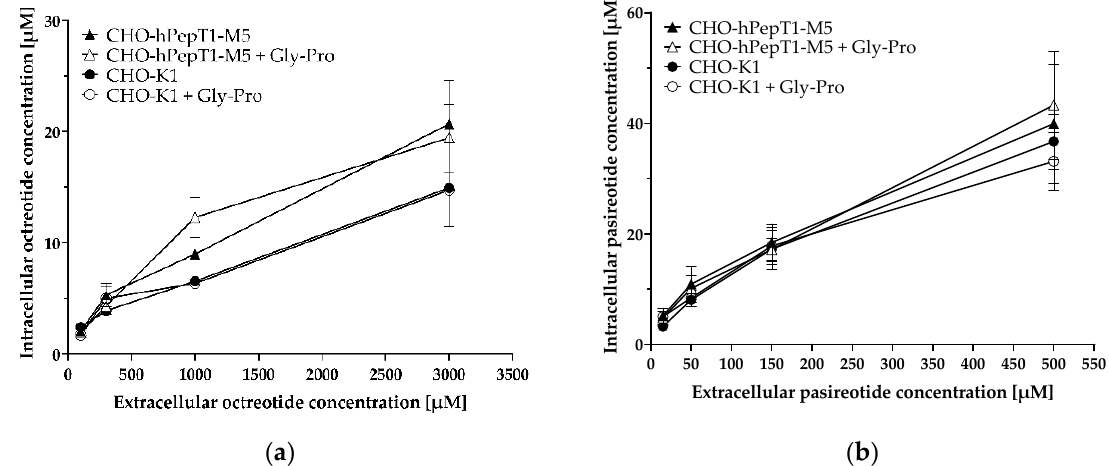
Figure 7. Uptake of octreotide ( a ) and pasireotide ( b ) in CHO-hPepT1-M5 cells and CHO-K1 cells with and without the inhibitor Gly-Pro. Cells were incubated for 10 min with the respective peptides. Each data point represents the mean ± S.E.M. for three experiments with each concentration tested in triplicate.